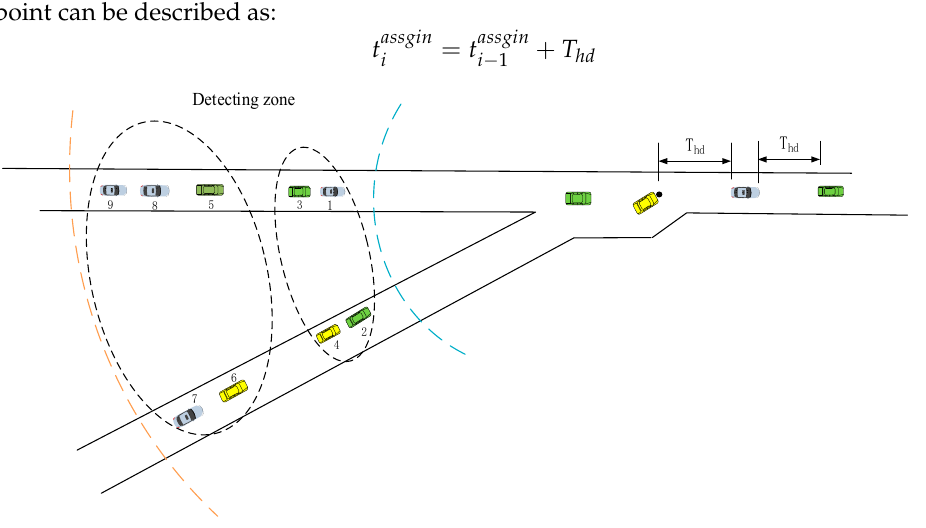
Figure 2. Vehicles clustered in the detecting